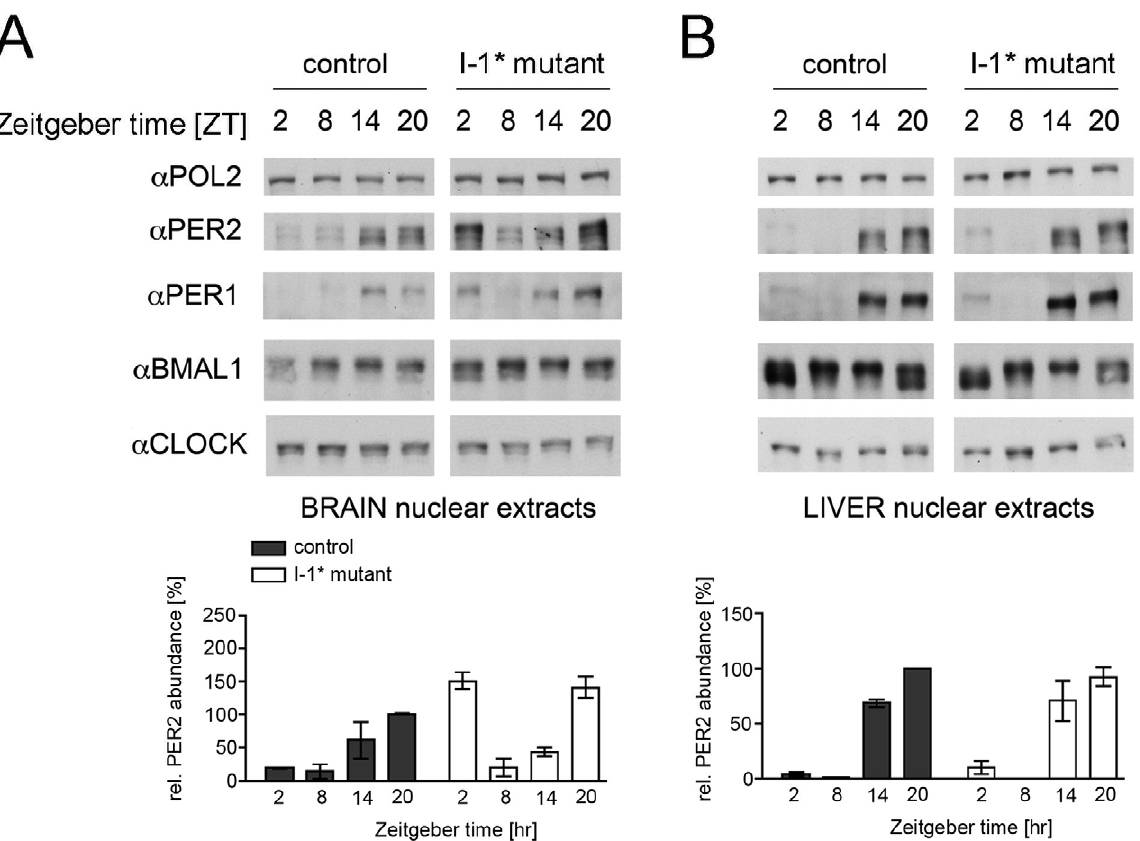
Figure 4. Protein expression in nuclear extracts from brain and liver. Nuclear extracts from coronal brain slices containing the SCN (A; pool of two animals) and liver (B) from control and I-1* mutant mice under on dox conditions were prepared at 6-h intervals from mice held in a 12-h light/ 12-h dark cycle (LD 12:12 h cycle). The protein accumulation patterns were analyzed by Western blot analysis using the indicated antibodies. The accumulation of RNA polymerase II (antiPOL2) is shown as loading control. Below the quantification of PER2 levels in nuclear extracts from brain and liver is shown (n=4 animals; t-test control vs. mutant at ZT2 and ZT20, p , 0.05 for brain, p . 0.05 for liver).